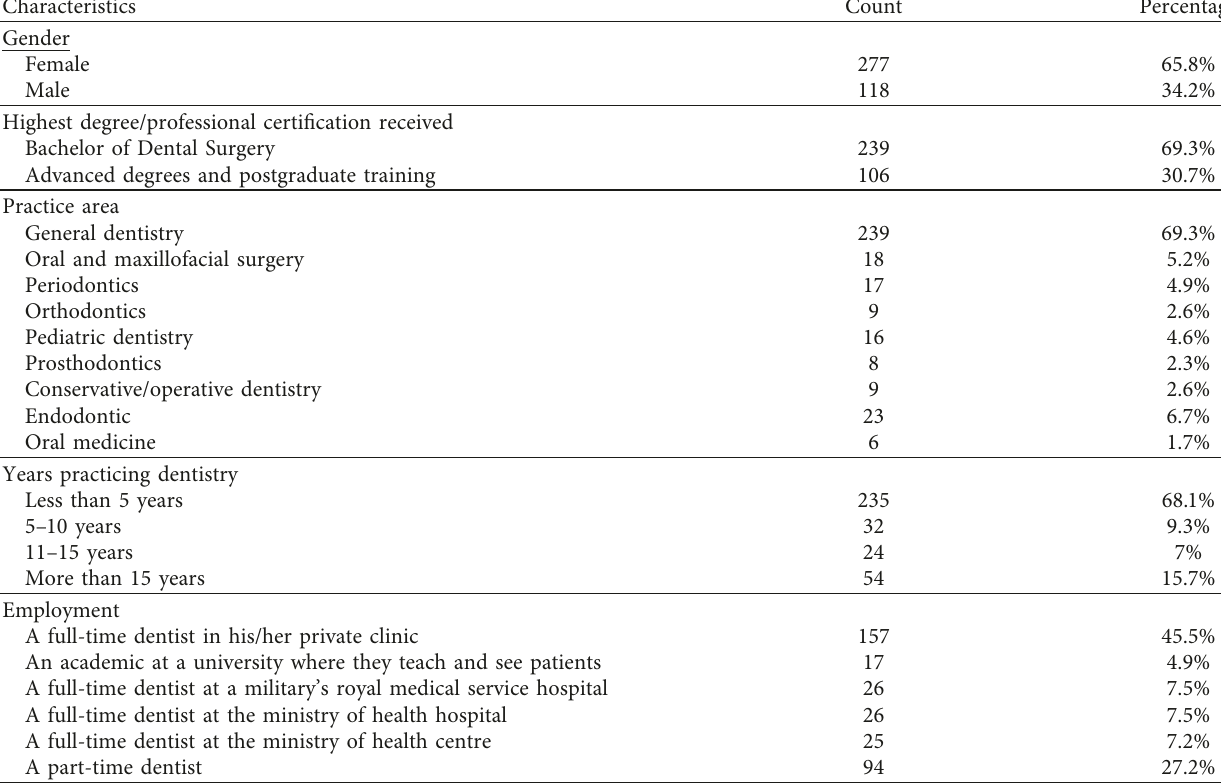
Table 1: Respondents’